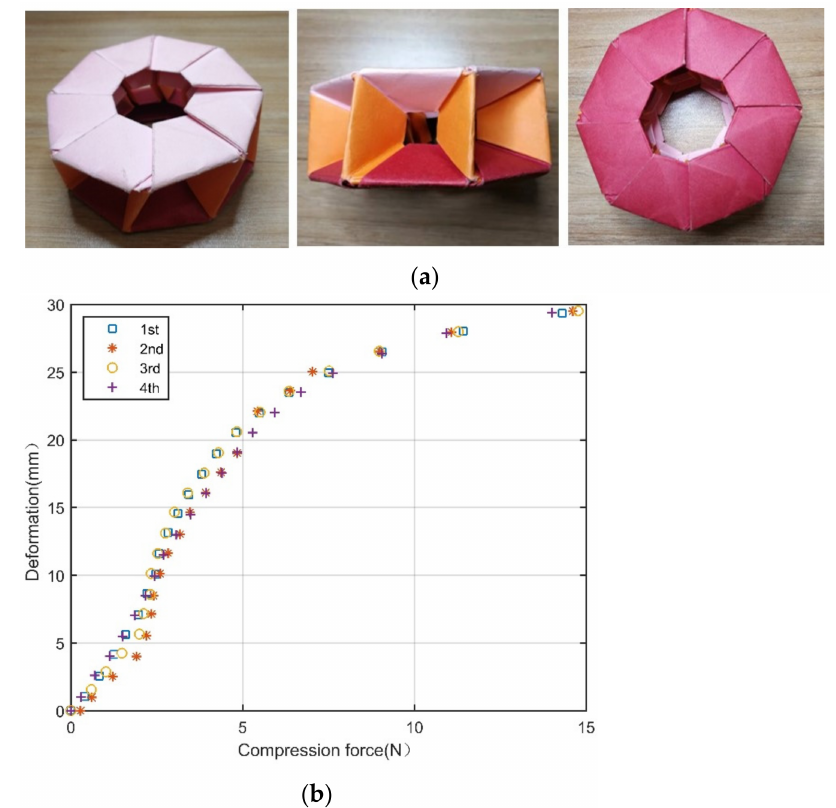
Figure 10. Experimental results with a one-layer structure after 500 cycles of contraction/extension: ( a ) one-layer structure with irreversible deformation; ( b ) results of compression force vs. deformation after 500